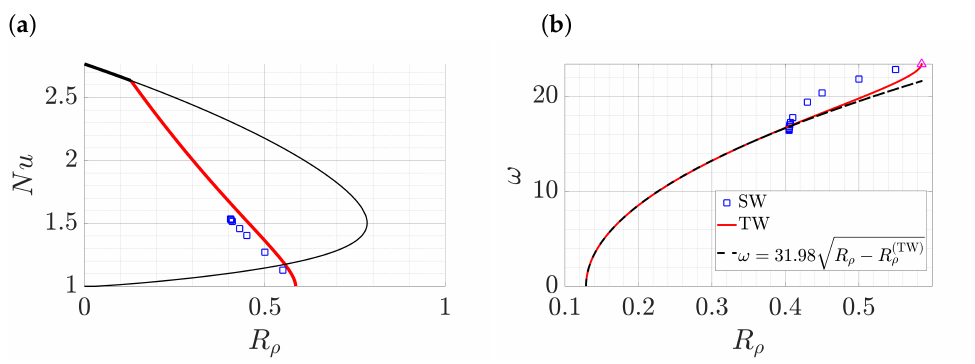
Figure 11. ( a ) Bifurcation diagram of single-mode solutions at Ra T = 100, Le = 20, k x = π and k y = 0 showing steady convection rolls ( ), SW ( (cid:3) ) and TW ( ). Thick lines indicate stable solutions and thin lines represent unstable solutions. ( b ) The temporal frequency ω = 2 π / T p of SW ( (cid:3) ) and TW ( ), the latter computed from ω = | c | k x . The Hopf frequency is ω Hopf = 23.40889 at the Hopf bifurcation point R ρ = 0.58548 ( (cid:52) ) from the trivial solution. Near the termination of the TW branch the phase velocity c of the waves decreases to zero at R theoretically